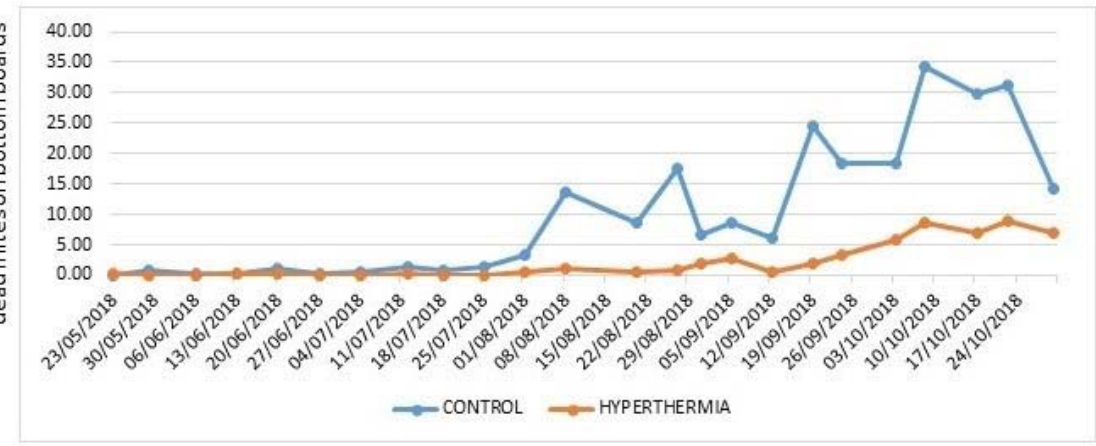
Figure 4. Average daily Varroa destructor mortality in 2018.